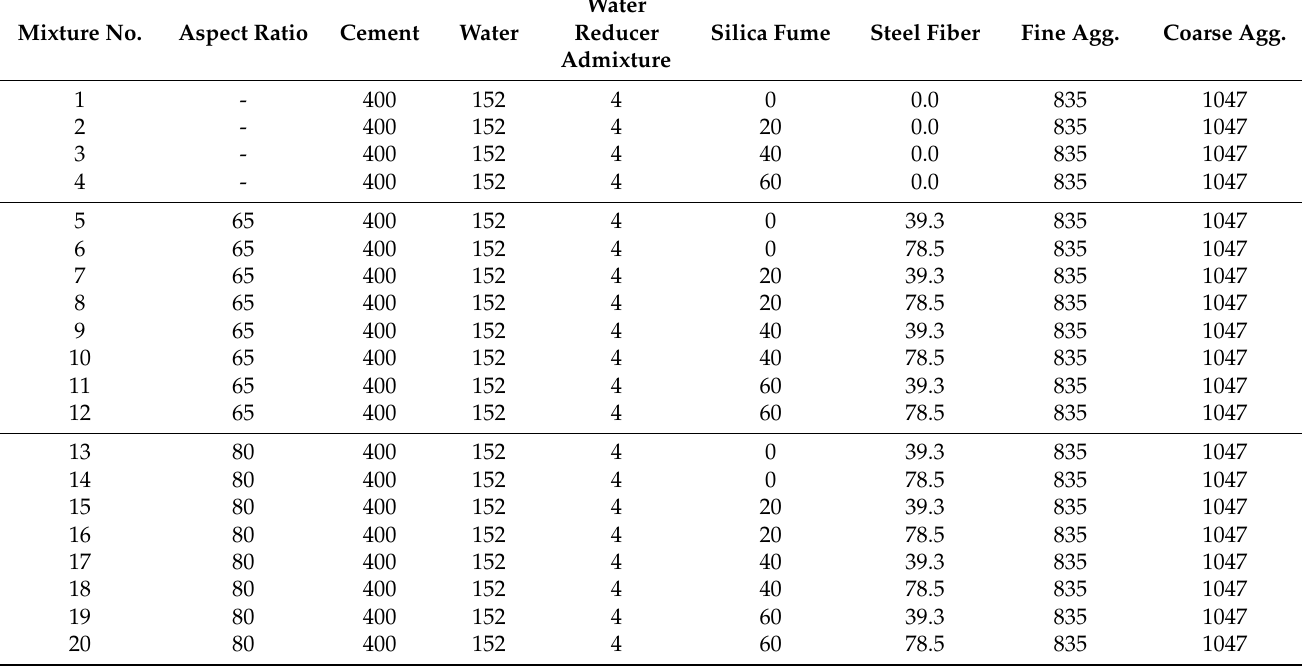
Table 1. Composition of concrete mixtures (kg/m 3